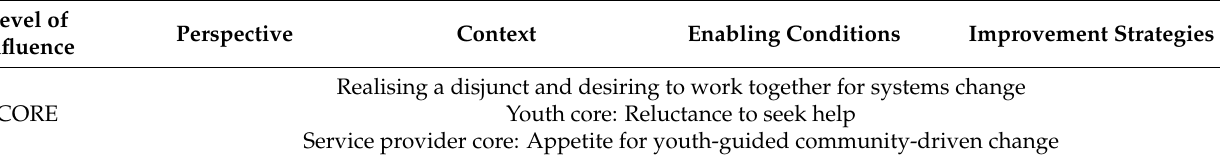
Table 3. Socio-ecological framework for improving Yarrabah youth wellbeing supports and services: Comparison of service provider and youth